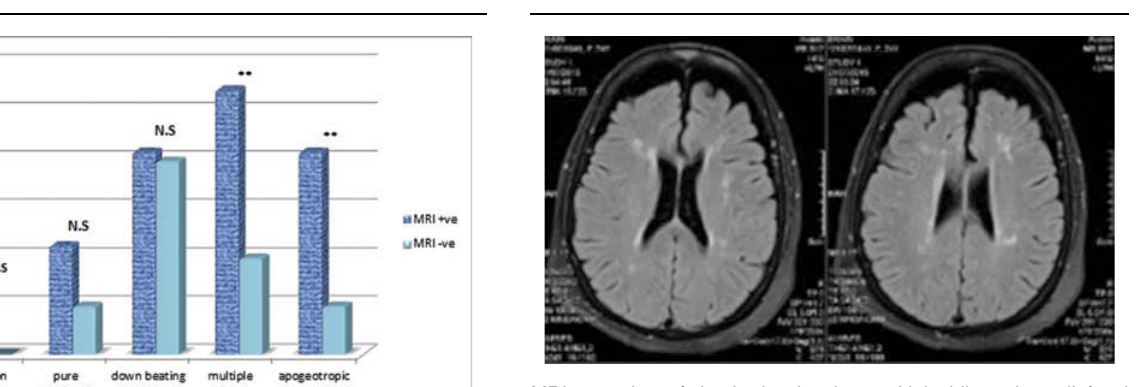
MRI scanning of the brain showing multiple bilateral small focal lesions, scattered along the periventricular white matter of both frontoparietal regions, suggesting multiple lacunar infarctions.